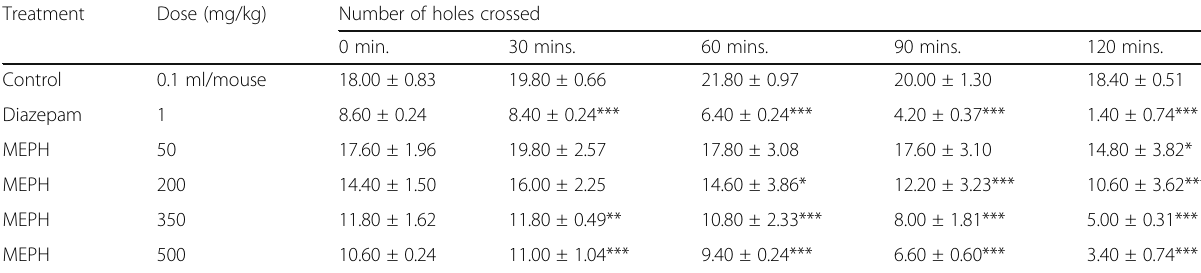
Table 3 The effect of MEPH on hole cross test in mice Treatment